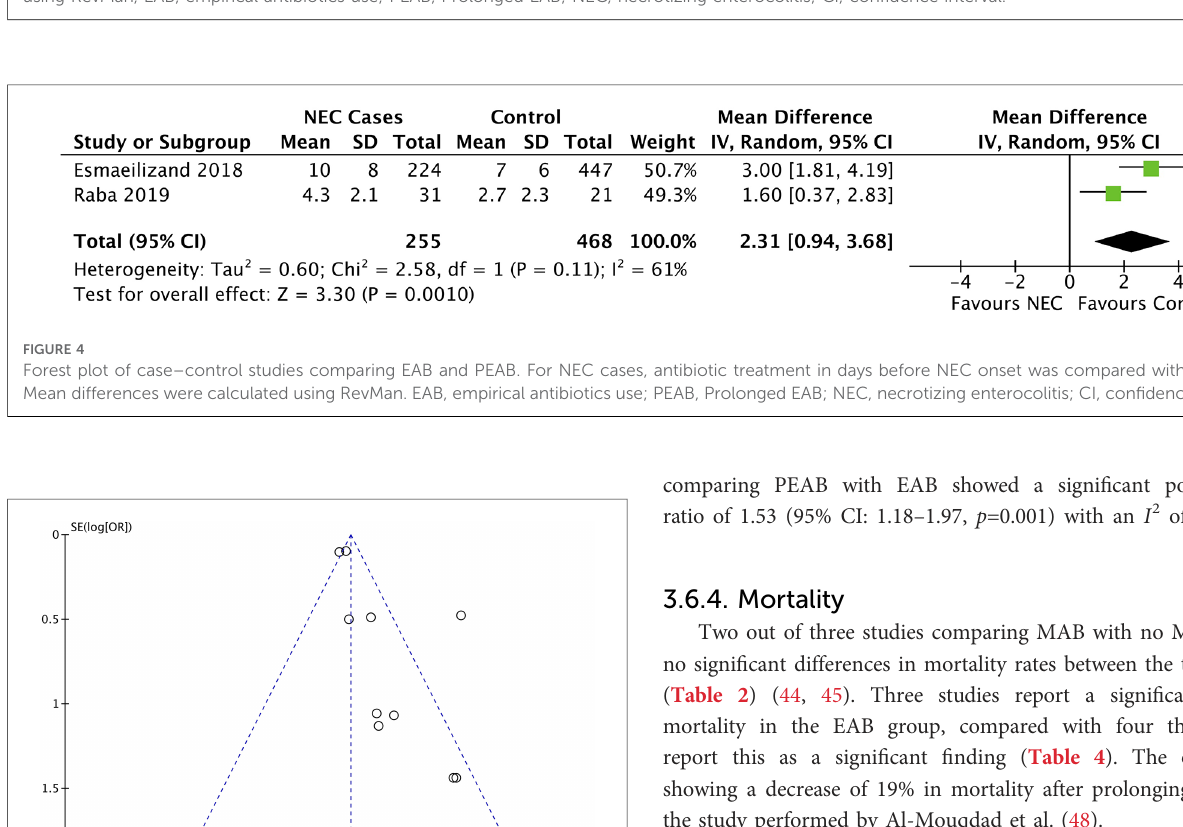
FIGURE 3 Forest plot of all included observational cohort studies comparing EAB and PEAB. Events=the incidence of NEC development. Odds ratios were calculated using RevMan, EAB, empirical antibiotics use; PEAB, Prolonged EAB; NEC, necrotizing enterocolitis; CI, con fi dence interval.